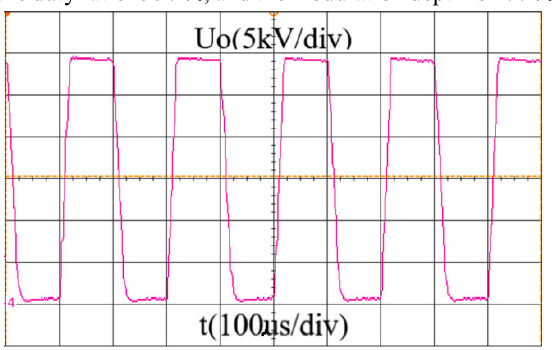
Fig. 7. The modulation output waveform of the ASIPP anode power.